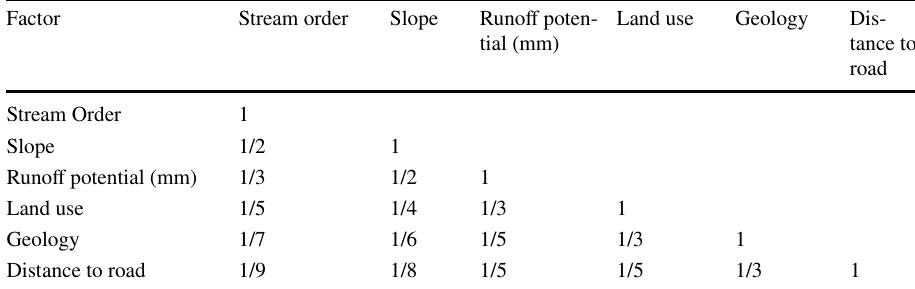
Table 5 Pairwise comparison of seven criterion matrix (Saaty, 1980; Saaty and Vargas 1991)